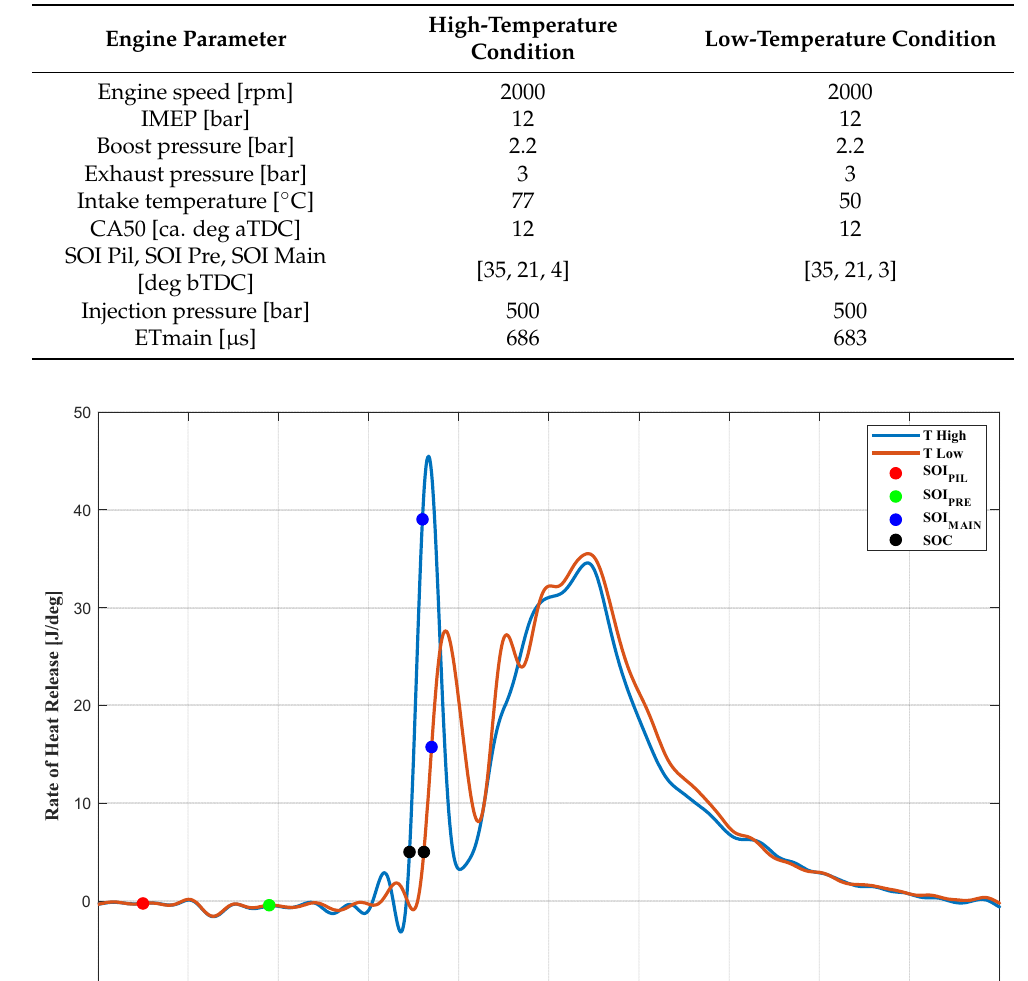
Figure 6. RoHR curves at different intake temperatures.